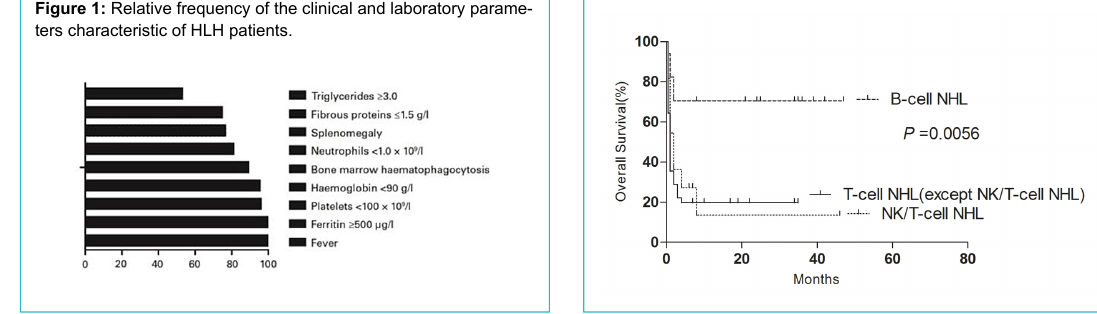
Figure 1: Relative frequency of the clinical and laboratory parame- ters characteristic of HLH patients.